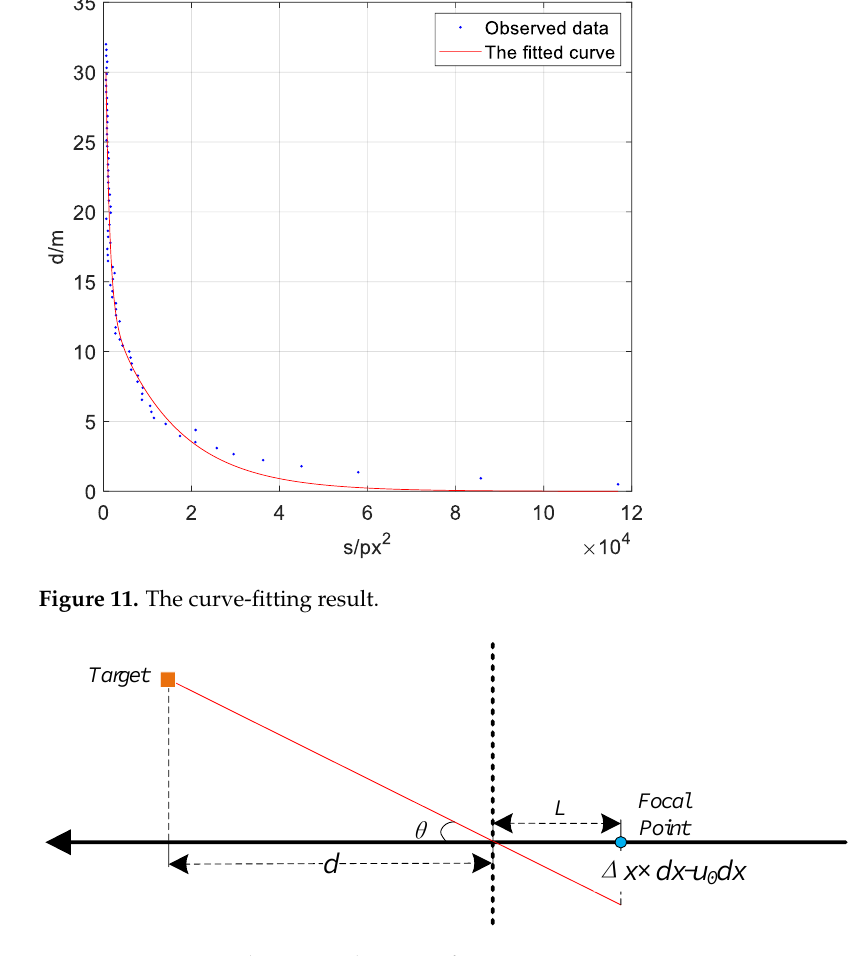
Figure 12. Horizontal imaging diagram of camera.